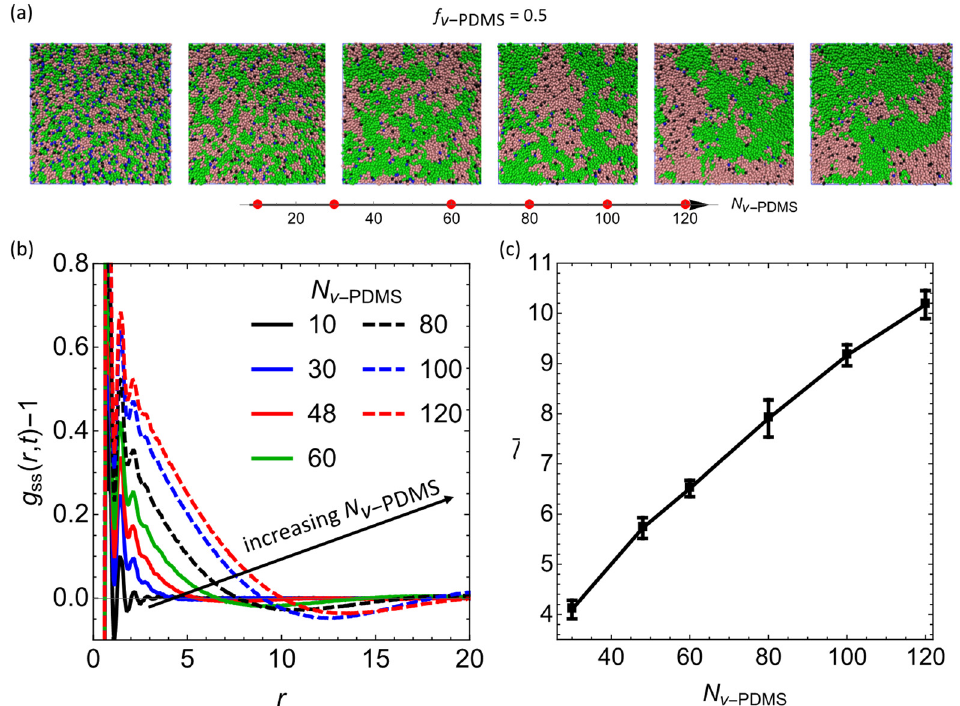
Figure 3. Effect of the degree of polymerization of the sacrificial component, N v − PDMS . ( a ) Equilib- rium morphology snapshots of the blends with f v − PDMS = 0.5 and various N v − PDMS . The values of N v − PDMS from the left to the right are 10, 30, 60, 100, and 120. ( b ) The g ss ( r ) − 1 at various N v − PDMS as listed in the legend. ( c ) The average equilibrium characteristic length scale l . Here and below, l is averaged over the data taken within the last five frames (upon reaching an equilibrium) for four independent simulation runs; the error bars correspond to the standard deviation.